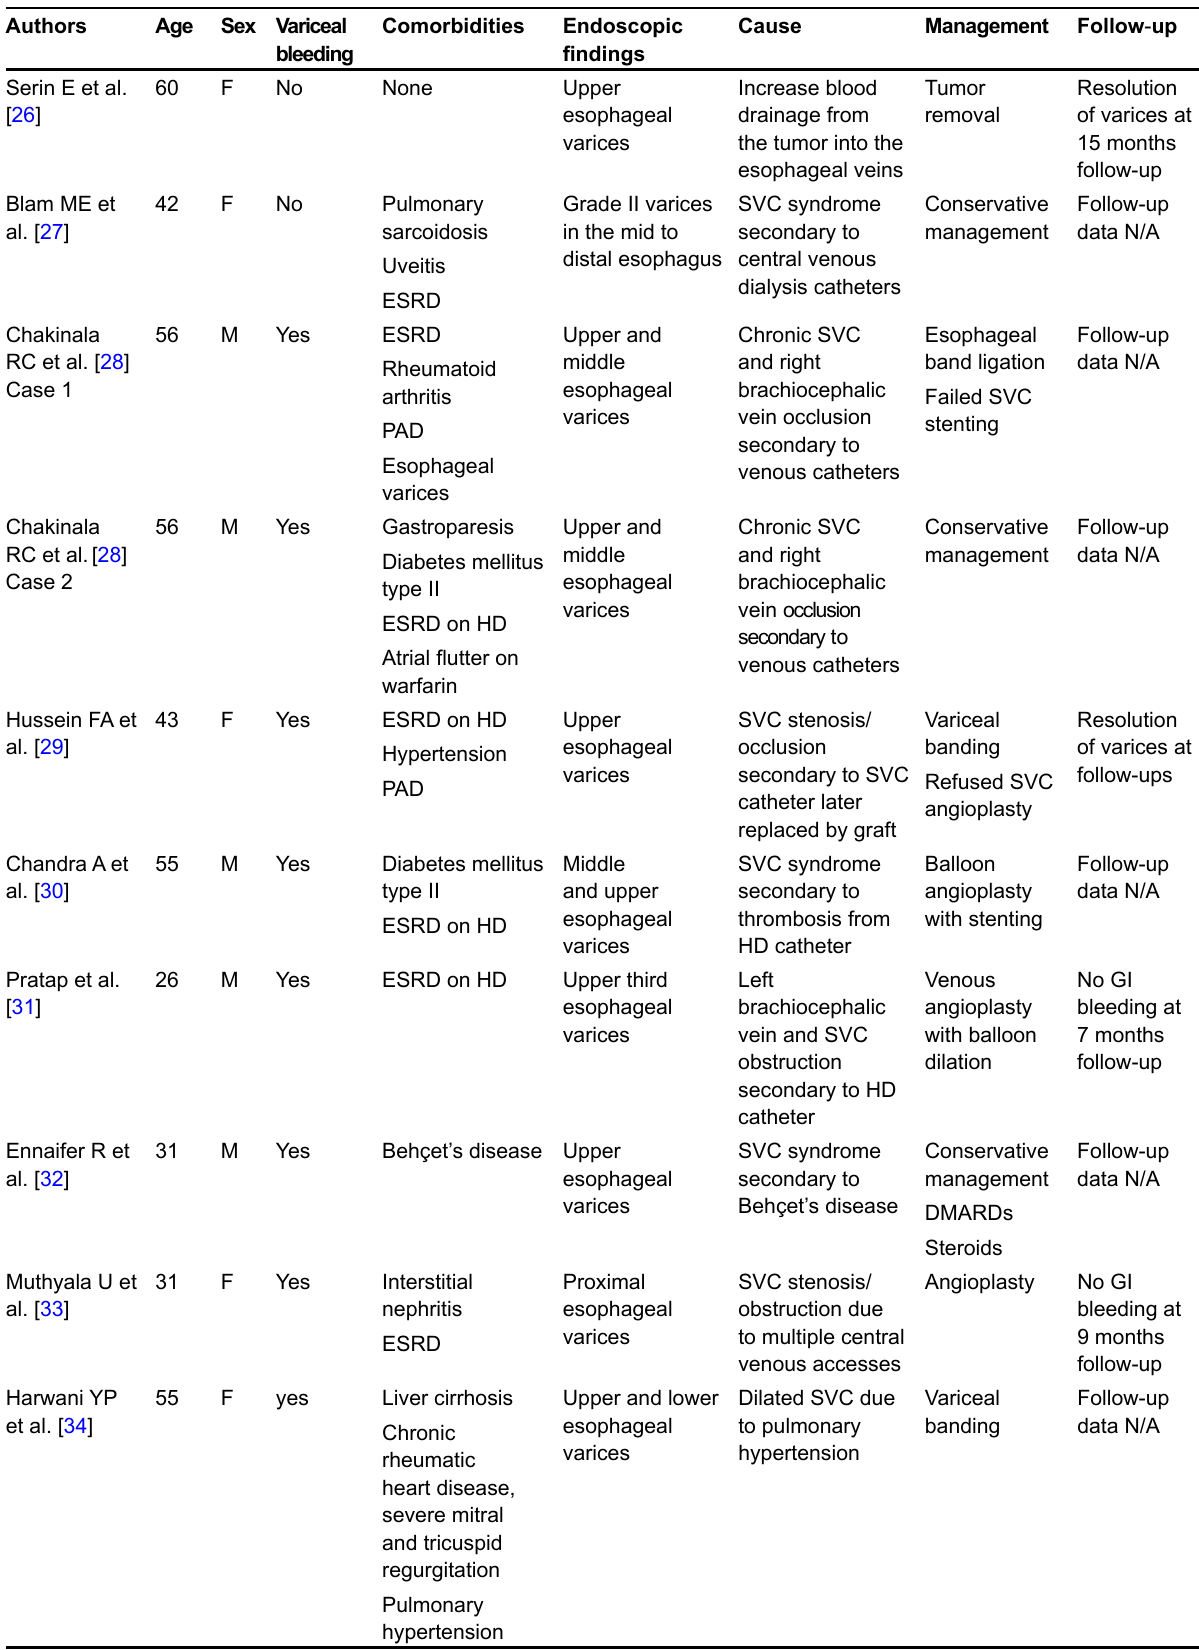
Table 1. Demographics, presentation, causes and management of patients with downhill varices ( continued ) Authors Serin E et